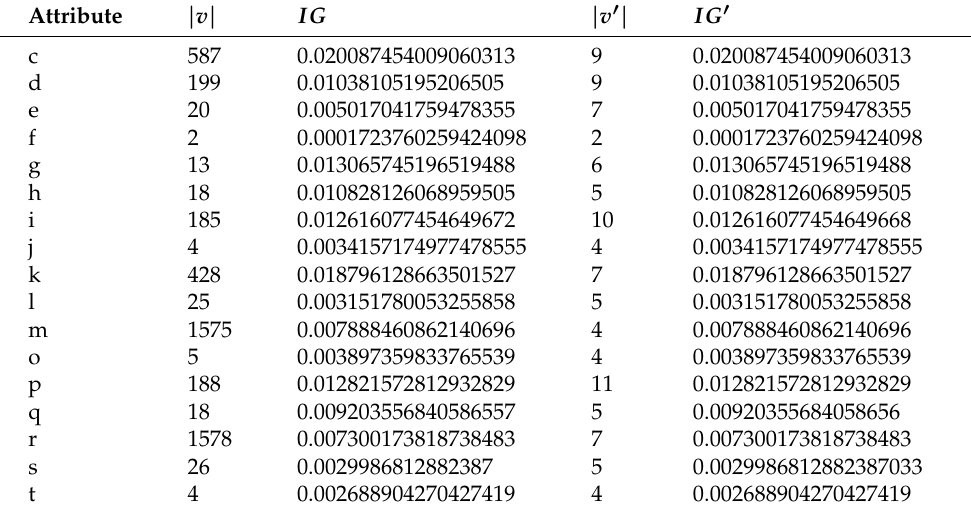
Table 3. The categorical attributes and their IG from Dataset 1.